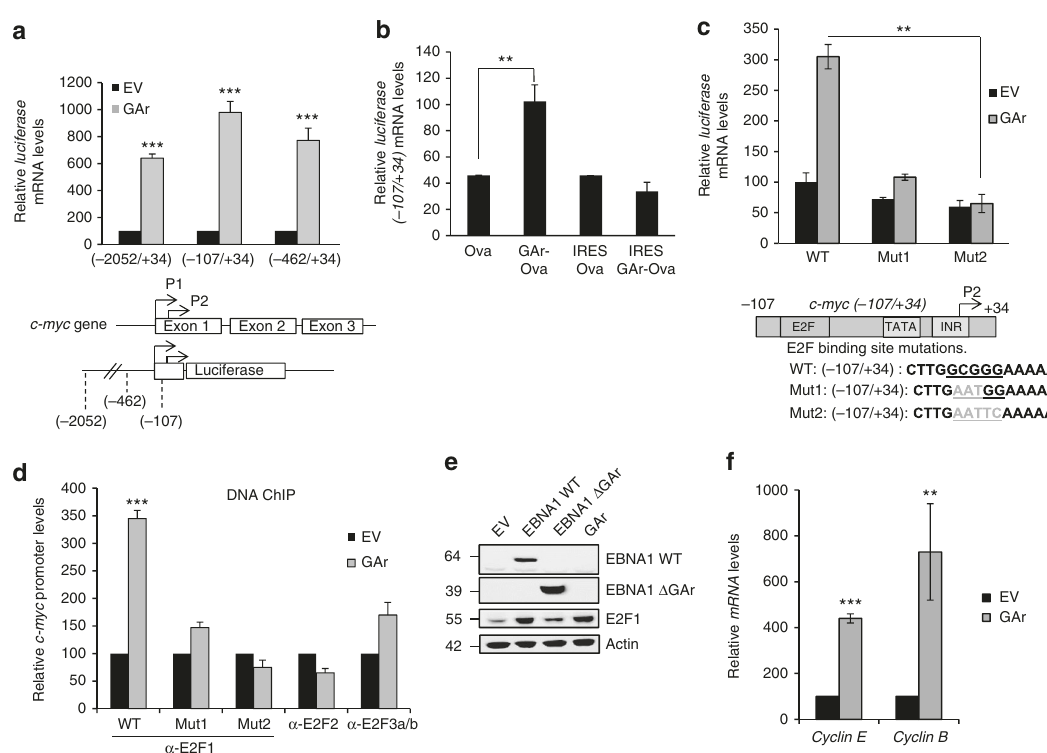
Fig. 2 E2F1 promotes GAr-dependent induction of c-myc . a RT-qPCR data show the relative induction of c-myc-luciferase (Renilla) reporter constructs (indicated in lower panel) following expression of the GAr, as compared to control plasmid (EV). b Relative RT-qPCR values show the induction of c-myc promoter activity from the ( − 107/+34) luciferase reporter construct using indicated Ova and GAr-Ova ( ± IRES) cDNA constructs. c Relative RT-qPCR values from the ( − 107/+34) luciferase reporter constructs carrying either three (Mut1) or fi ve (Mut2) point mutations in the E2F1 consensus binding site (indicated in lower panel). d DNA chromatin IP (ChIP) assay using the ( − 107/+34) sequence of the c-myc promoter constructs (WT, Mut1 and Mut2) and antibodies against E2F1, E2F2 or E2F3 from cells expressing the GAr or EV. e Western blots showing the E2F1 levels in cells expressing EV, EBNA1 WT, EBNA1 Δ GAr or GAr with actin used as loading control. f RT-qPCR data of the induction of the E2F1 target genes Cyclins E and B following expression of GAr. For RT-qPCR, the values were normalised with GAPDH. The values represent the mean data from three independent experiments with s.d. Signi fi cance was calculated using t tests (*** p < 0.001 and ** p <